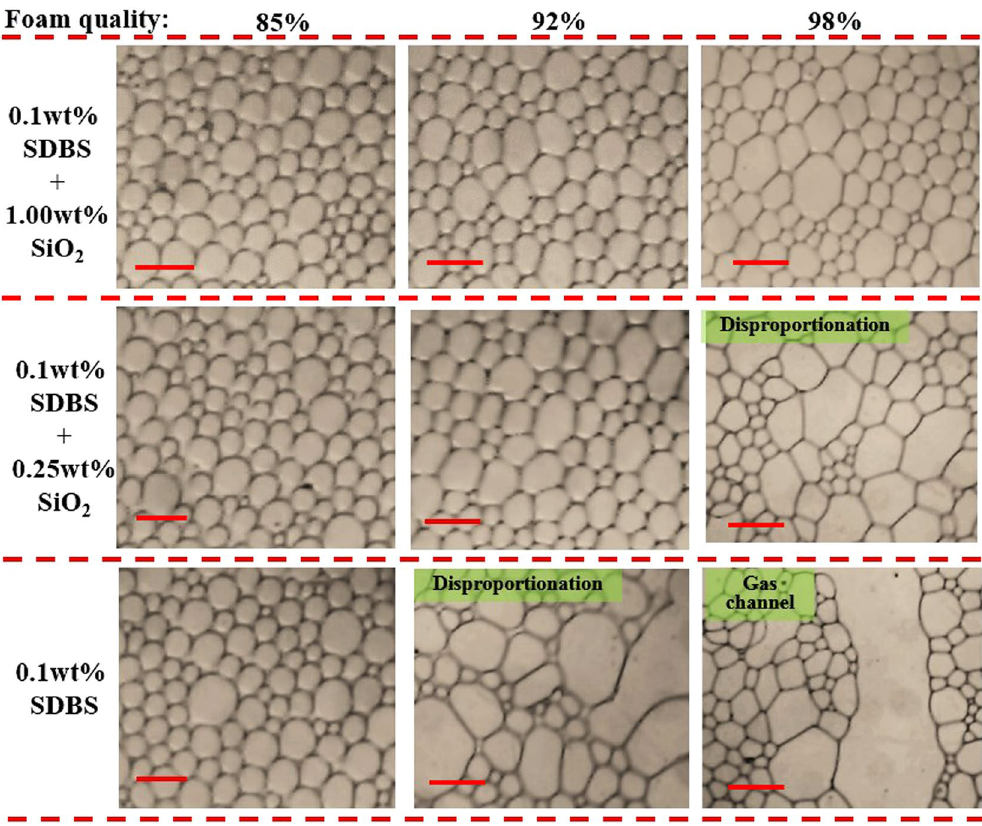
Figure 12. Optical micrographs showing different foam microstructures during flow in cracks for different SDBS/SiO